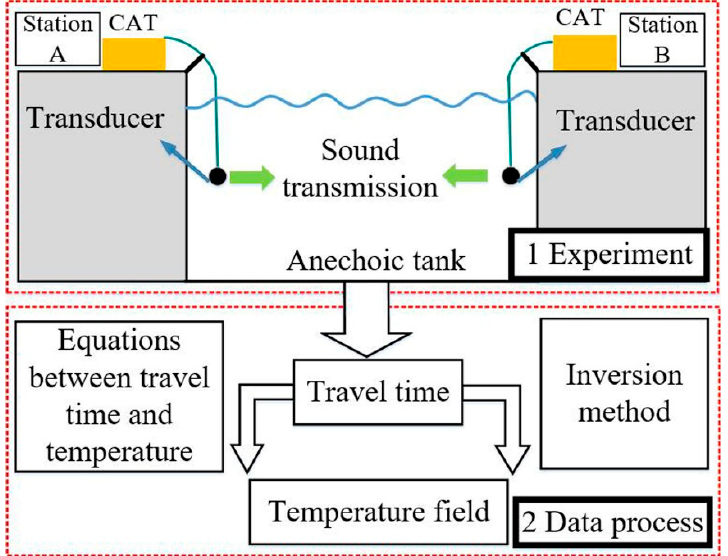
Figure 1. Field observation process using coastal acoustic tomography CAT.